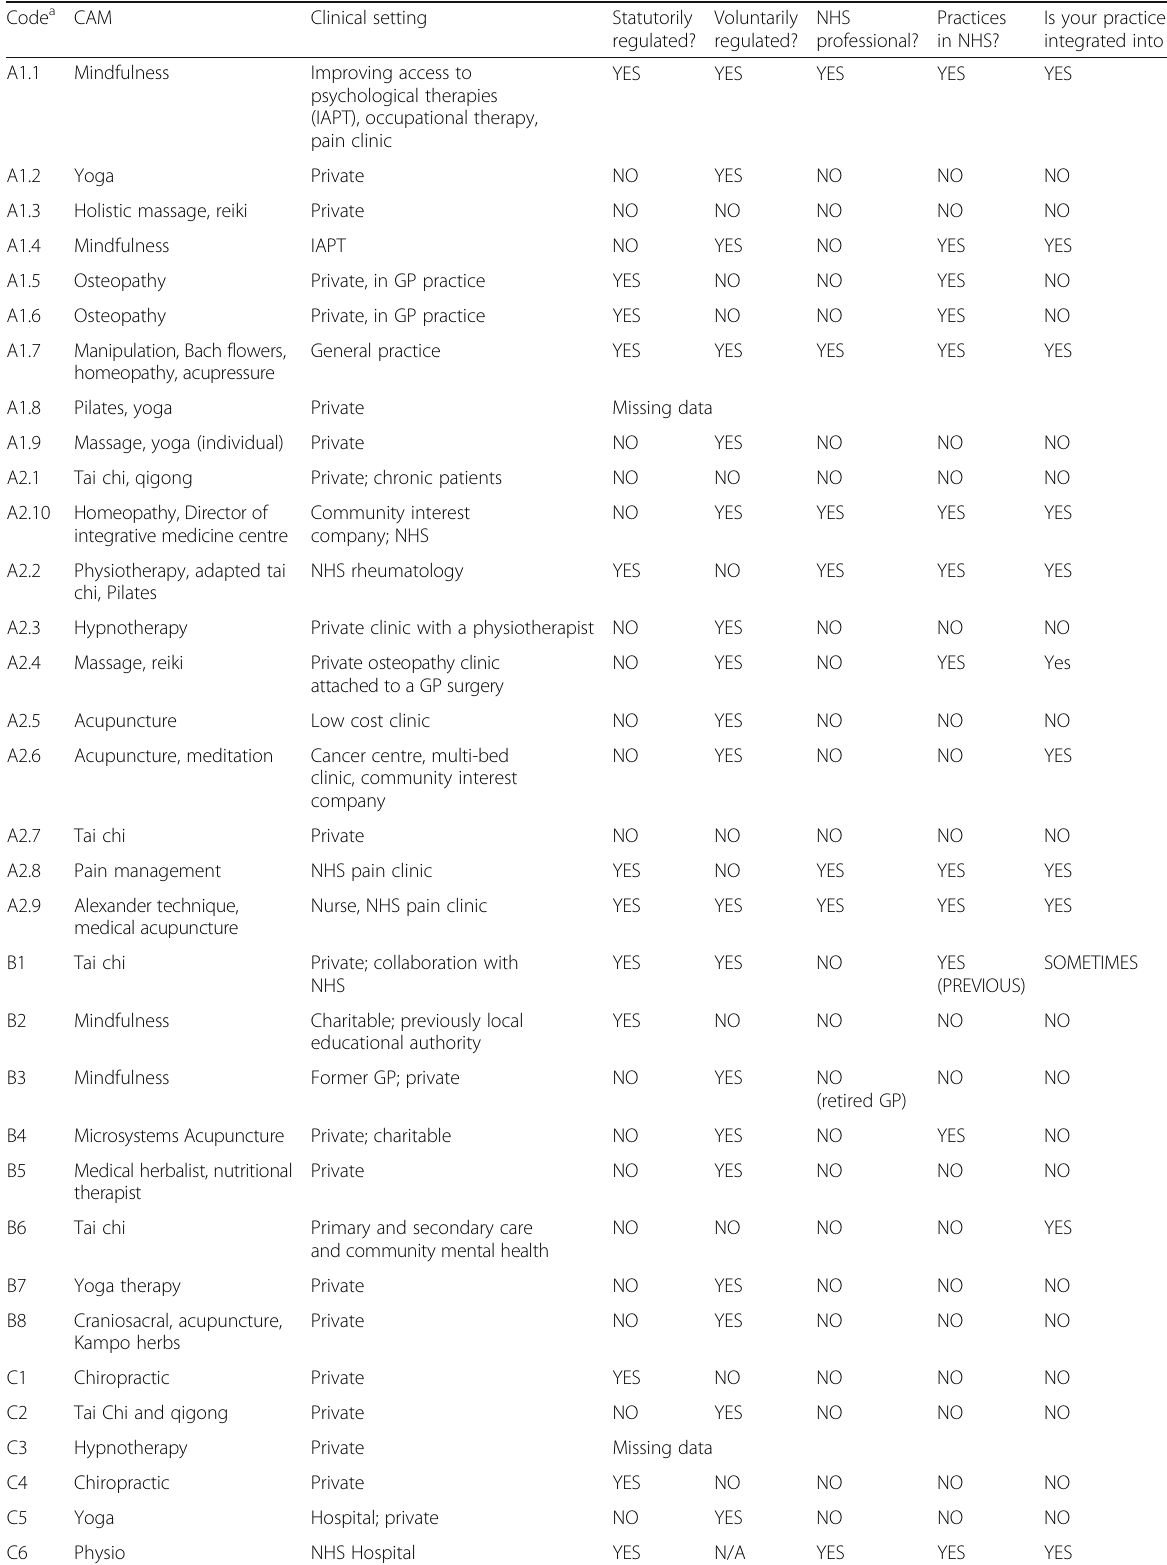
Table 1 Participants in CAM practitioner focus